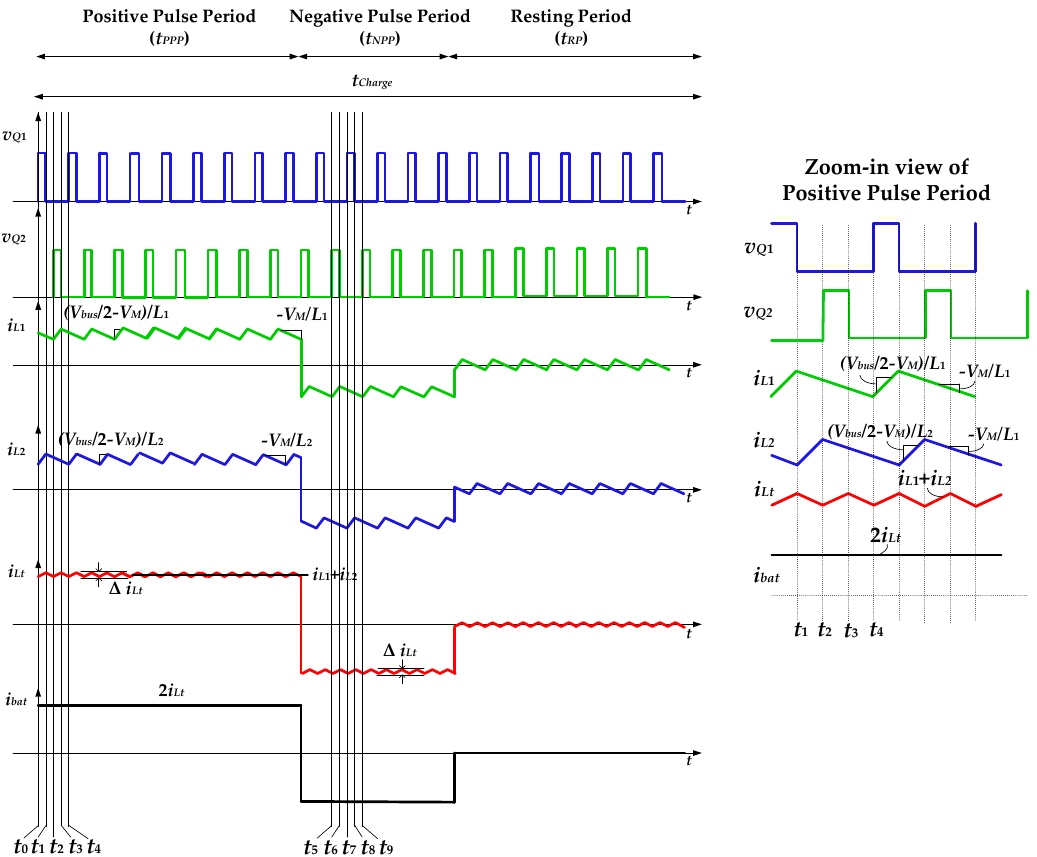
Figure 2. Schematic waveforms of the proposed high-gain RC-BDC at charging state.